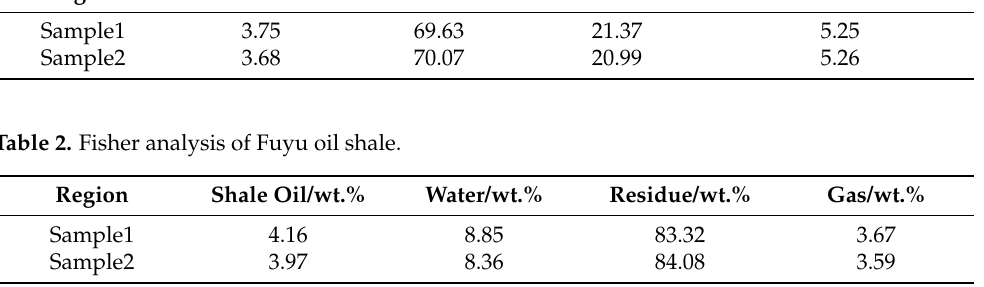
Table 1. Proximate analysis of Fuyu oil shale. Region Moisture/wt.% Figure 1. Wells location of oil shale in-situ pyrolysis and geophone deployment for monitoring hydraulic fracturing. (The yellow marks are representing the geophone).